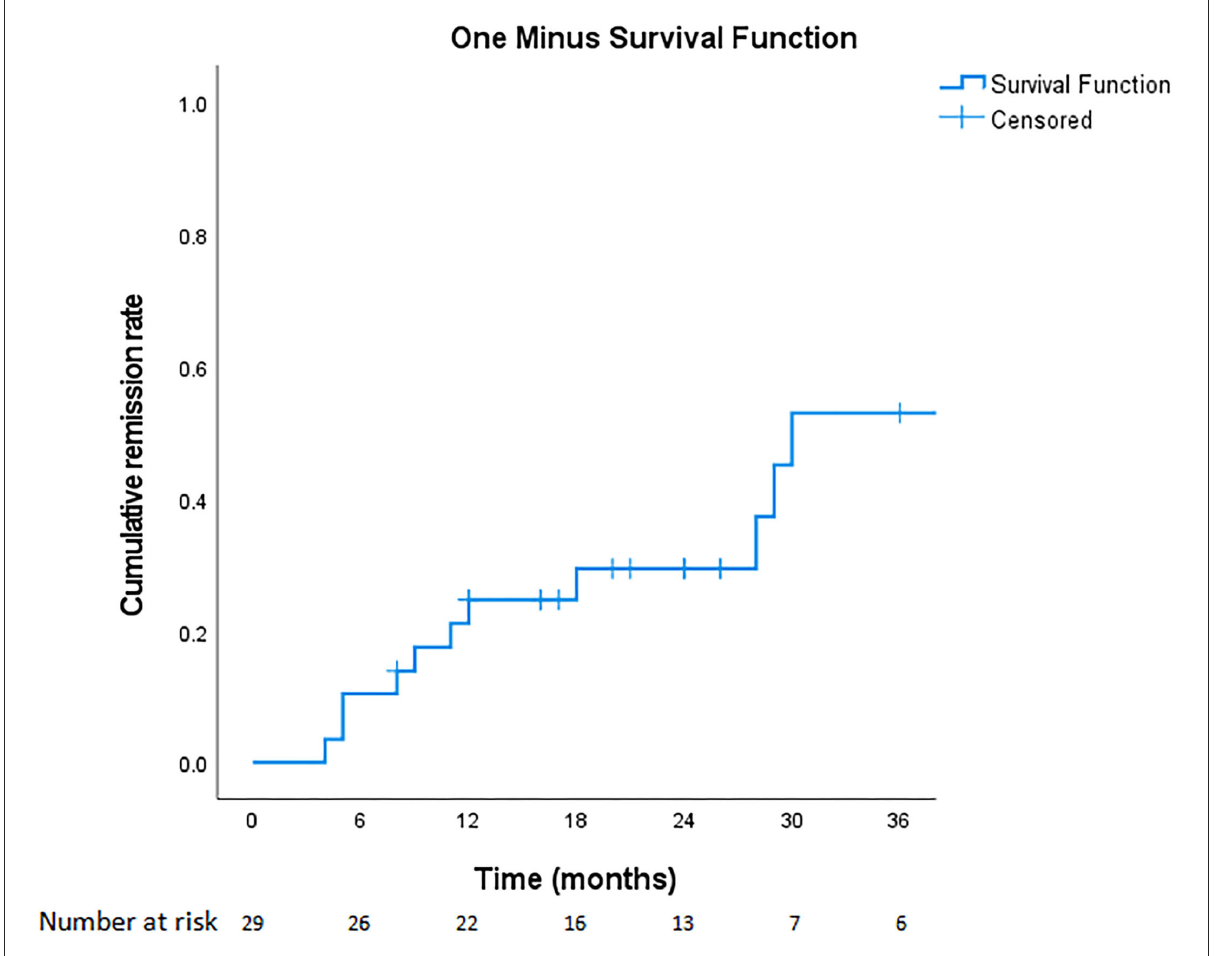
FIGURE3 Cumulative remission rate since medication treatment for